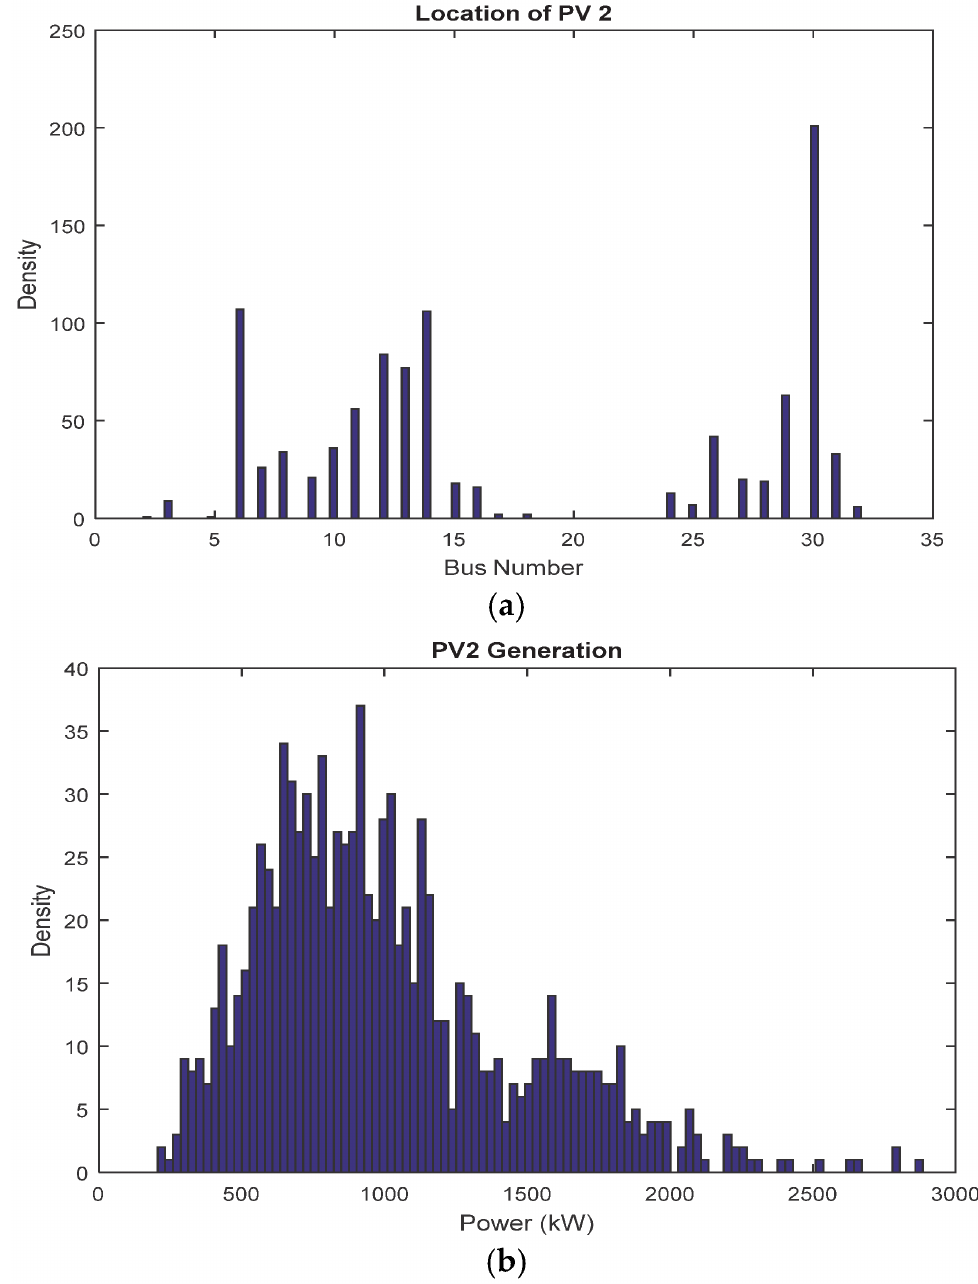
Figure 14. The PDF of placement and size of 2nd PV in the 33-bus system with uncertainties using IHLOA: ( a ) location of 2nd PV; ( b ) 2nd PV